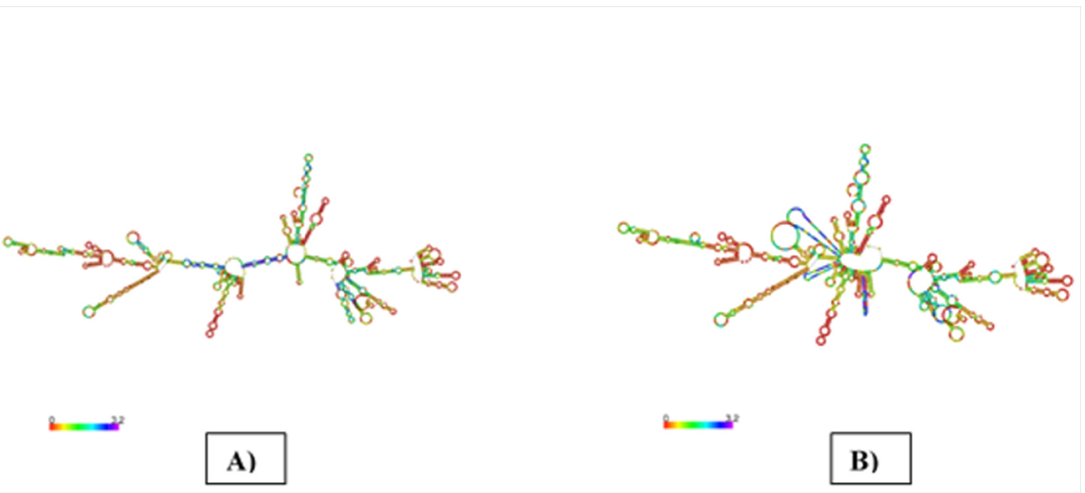
Figure 4. mRNA structure prediction: ( A ) optimal secondary structure; ( B ) centroid secondary structure of the vaccine mRNA retrieved using an RNA-fold internet-based server.